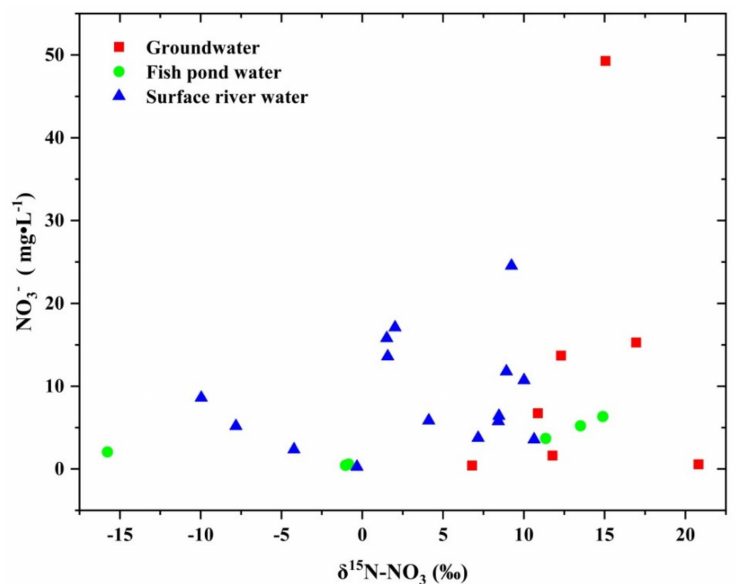
Figure 6. The relationship between δ 15 N-NO 3 and NO 3 − .